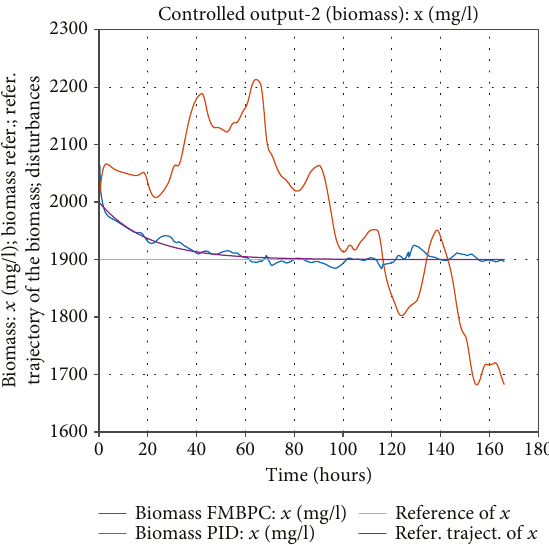
Figure 20: E ffl uent substrate by FMBPC and PID (case C).